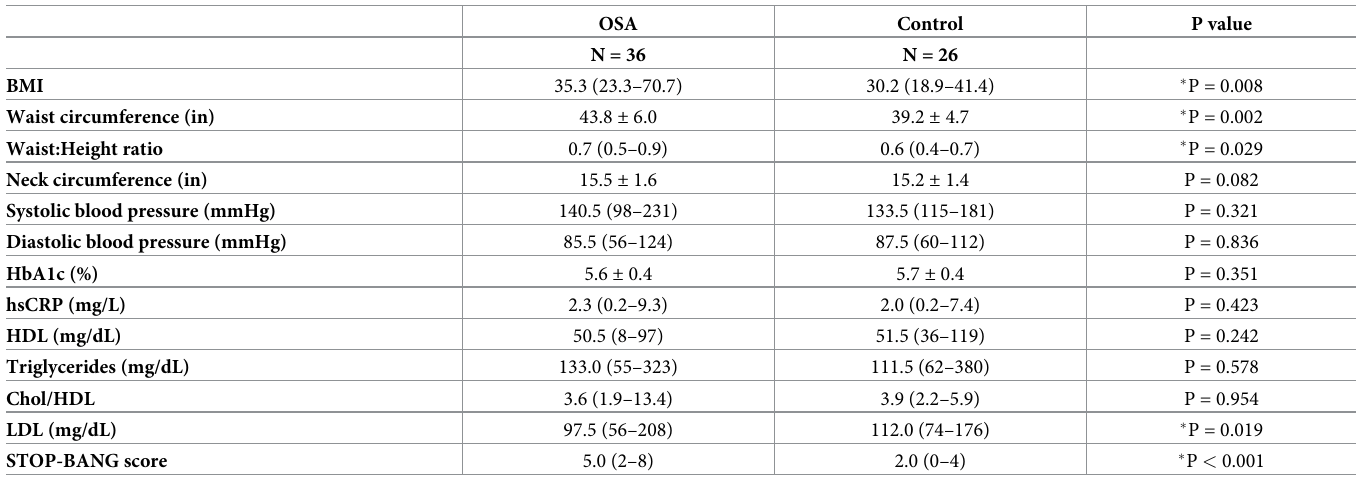
Table 2. Anthropometric measurements and